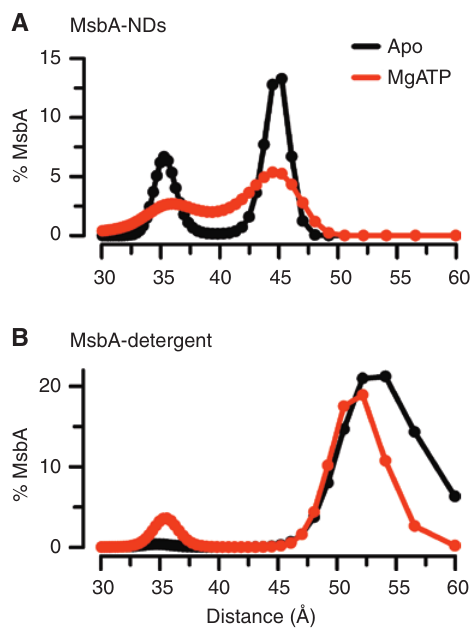
Figure 7: Distance distributions in the apo state and during hydrolysis. Distance distributions calculated from the lifetime distributions of LRET sensitized emission intensity decays in the apo state and during ATP hydrolysis. Black, apo; red, continuous ATP hydrolysis in the presence of Mg-ATP. (A) Distance distributions in MsbA-NDs. (B) Distance distributions in